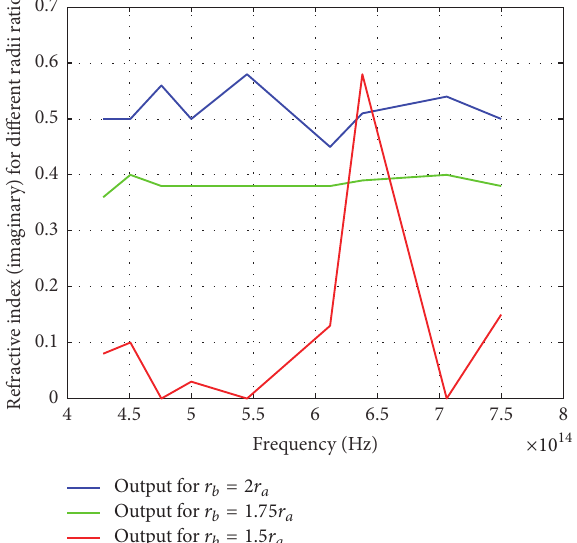
Figure 10: Plots for the imaginary component of refractive index versus frequency for different radii ratio.